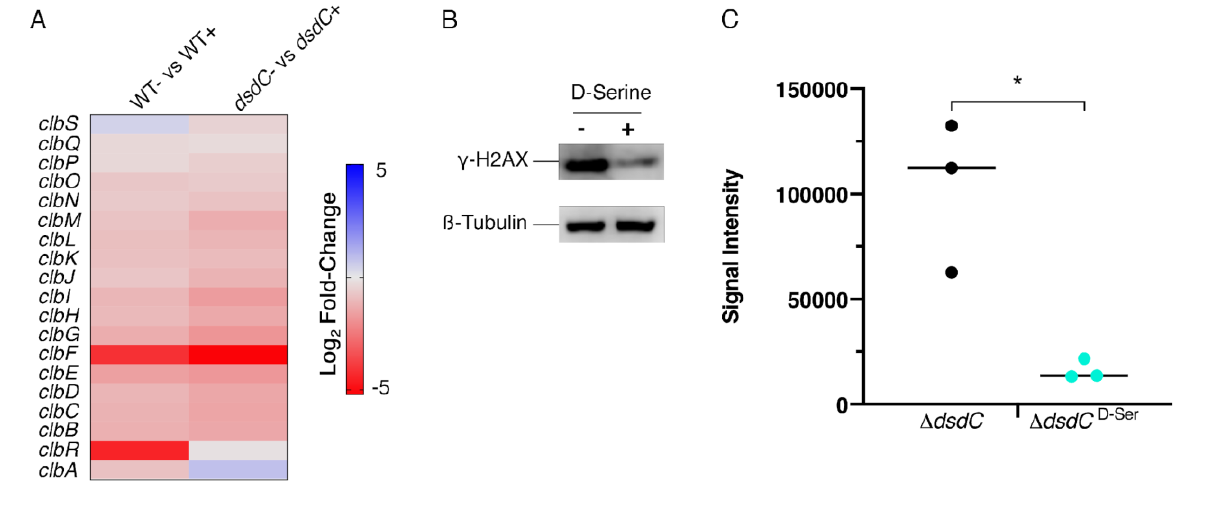
FIGURE 6: Deletion of dsdC does not affect D-Serine associated repression of colibactin. Generation of an isogenic mutant, Nissle Δ dsdC, revealed that D-Serine-associated repression of colibactin activity occurred independently of the D-Serine tolerance locus in pks + E. coli strains . ( A ) Heat map showing the EdgeR calculated log 2 relative fold changes for each gene in the pks island with corresponding colour key adjacent. False discovery rate-corrected P values can be found in Table S1. ( B ) The genotoxic activity of Nissle Δ dsdC was assessed by infect- ing HeLa cells as discussed above. Proteins were extracted and the level of H2AX phosphorylation was determined. Immunoblot analysis of cell lysates extracted 4 h post-infection is shown. Anti- γ -H2AX antibody was used as an indicator of double stranded DNA breaks and β - Tubulin was used as a loading control for cell lysates. ( C ) Signal intensities of bands were measured as described in the methods using LI- COR Image Studio. γ -H2AX signals were corrected to account for any variation in load ing using β -Tubulin signal intensity. Experimental signal was normalized so that the mean signal intensity of the samples was equivalent for each experiment. The experiment was carried out in triplicate. Columns represent mean +/- SEM with individual experimental observations indicated by data points. Statistical significance was assessed by unpaired Student’s t -test with, * indicating P <